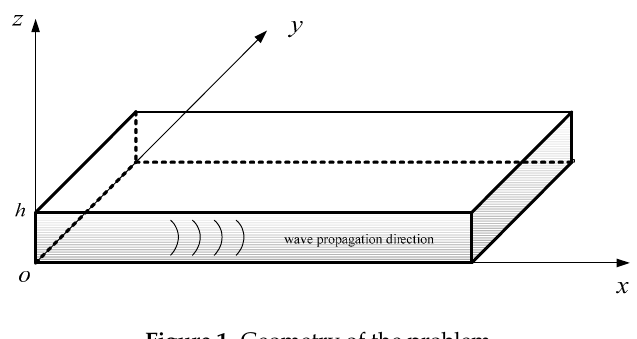
Figure 1. Geometry of the problem.